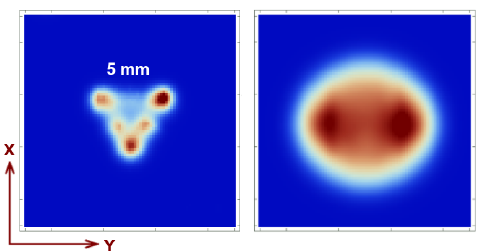
Figure 11. Image reconstruction of 5 mm Derenzo like spherical phantom (with 0.1 MBq activity of each sphere) at z = 4 cm and 1 min acquisition time ( left ) and the uniformity phantom ( right ) placed at z = 5 cm with 1 cm height and 5 cm diameter, for a 3 min acquisition and 0.1 Mbq